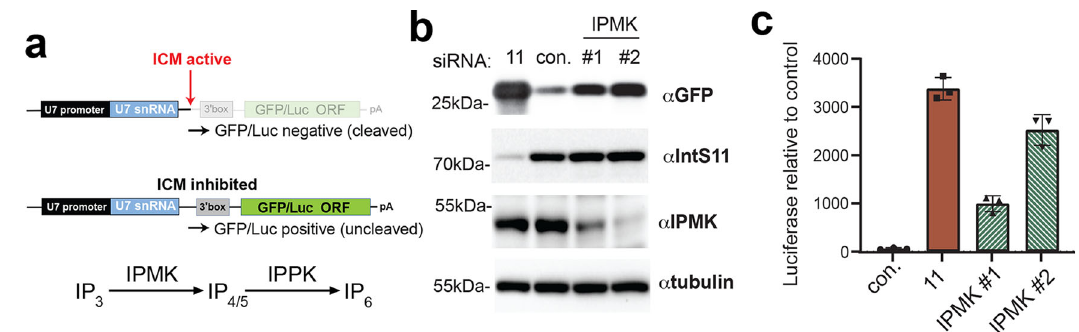
Fig. 8 | Downregulation of IP 6 biosynthesis disrupts Integrator function. a Schematic of the U7snRNA reporter systems, where the U7 gene is cloned upstream of GFP or luciferase. Top: in WT cells, the ICM drives RNA Pol II termi- nation and prevents GFP/luc expression. Bottom: Upon losing ICM function through IPMK depletion, RNA Pol II productively elongates through the GFP/luc ORF, yielding expression. The Integrator cleavage site is indicated with the red